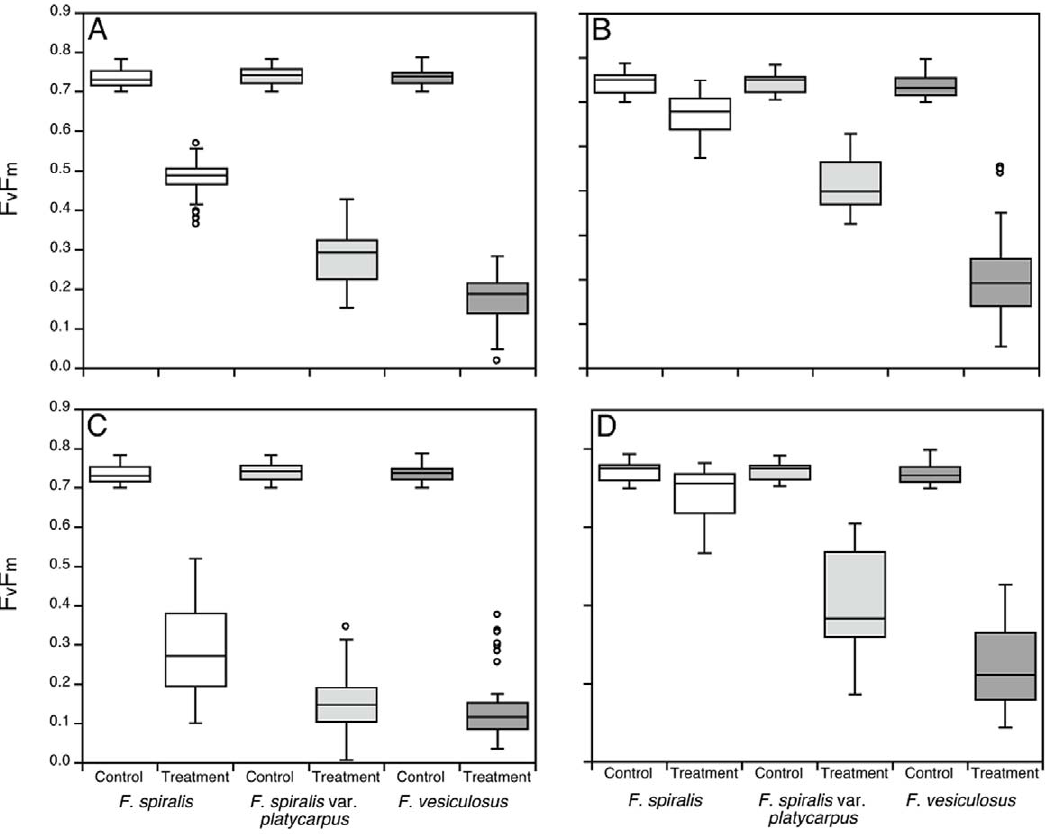
Figure 5. Physiological resilience to air exposure. Measurements of photoinhibition of PSII maximum quantum yield of F. spiralis , F. spiralis var. platycarpus and F. vesiculosus (zones pooled) after recovery from the following treatments: (A) and (B) morphotypes air exposed at 33 u C ( 6 0.5 u C) at a PPFD of 250–300 m mol ? m 2 2 ? s 2 1 (HL) after 1 and 6 hours of recovery respectively; (C) and (D) morphotypes air exposed at 37 u C ( 6 0.5 u C) in HL after 1 and 6 hours of recovery respectively.